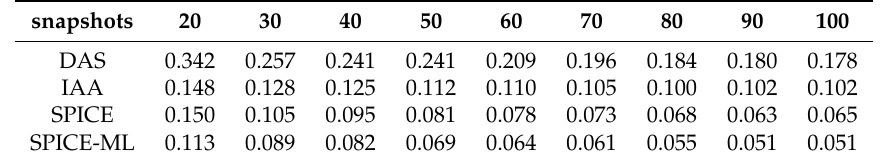
Table 3. RMSE vs. snapshots with independent signal.